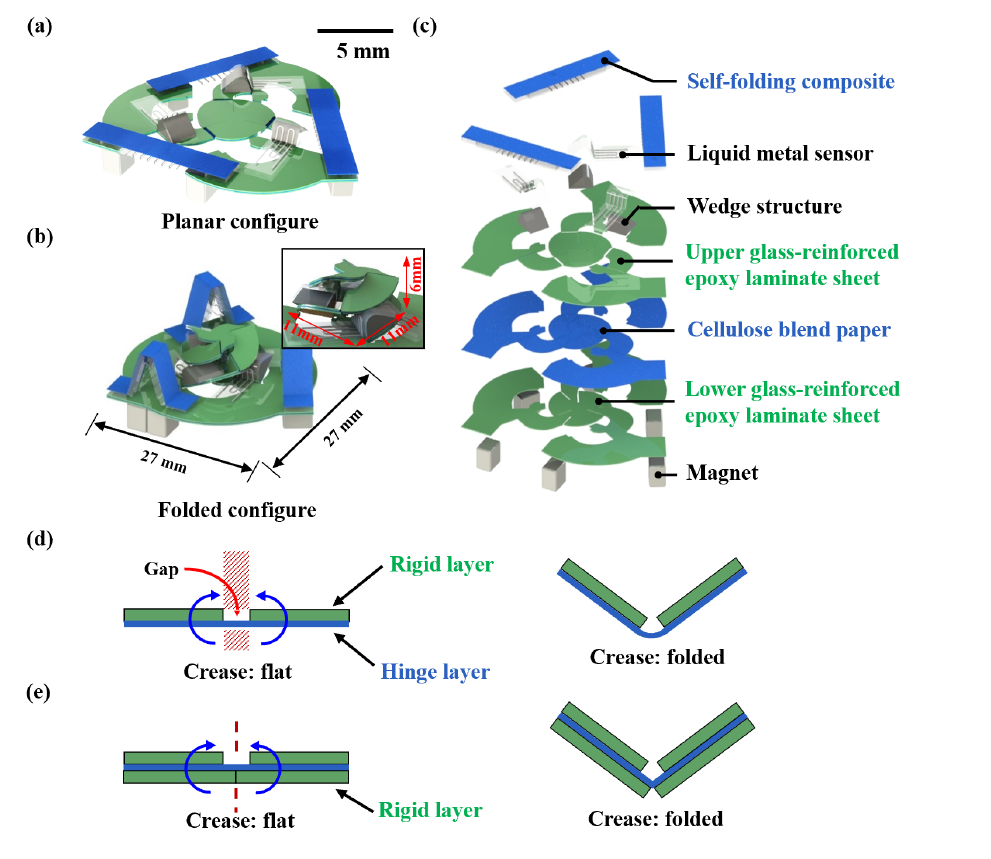
Figure 2. Design of the miniature soft sensor. ( a ) Flat state configuration. ( b ) Folded configuration. The inset is an enlarged view of the origami structure with the liquid metal sensor. ( c ) Explosion diagram of the miniature soft sensor. The self-folding composite and the liquid metal sensor’s thicknesses are 900 µ m and 600 µ m. The thickness of the upper and lower glass-reinforced epoxy laminate sheet and the cellulose blend paper is 200 µ m. ( d ) An origami structure with a single rigid layer. The red shaded part represents the possible position of the rotating shaft. ( e ) An origami structure with double rigid